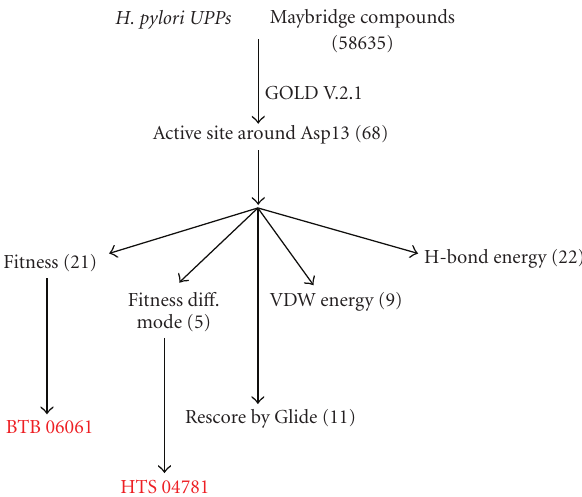
Figure 2: The flow chart for computer screening of H. pylori UPPS inhibitors. The active zone for screening was focused on Asp13, an important amino acid residue for coordinating with catalytic Mg 2+ . In parentheses are the numbers of compounds. BTB06061 and HTS04781 are the final